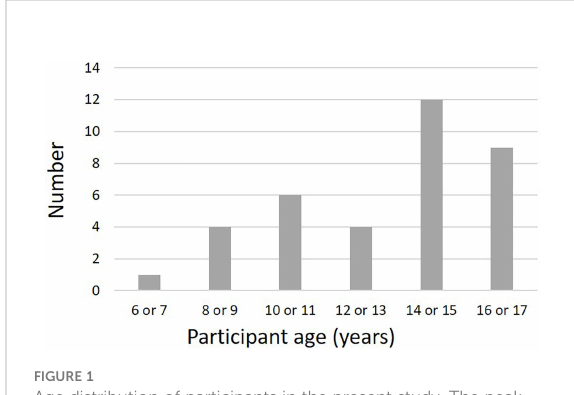
FIGURE 1 Age distribution of participants in the present study. The peak age groups were 14 – 15 years and 16 – 17 years. Participants also included 11 prepubertal children ≤ 11 years old. The youngest participant was 6 years